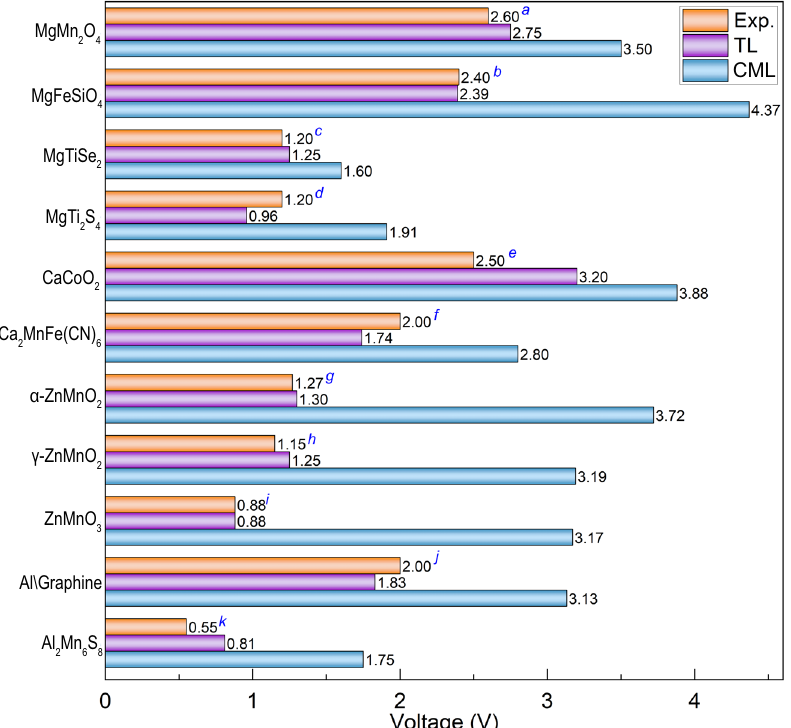
Fig. 4 Comparing the predicted voltages with the TL and conventional ML models with the available experimental values. a Ref. 58 . b Ref. 59 . c Ref. 60 . d Ref. 61 . e Ref. 62 . f Ref. 63 . g Ref. 64 . h Ref. 50 . i Ref. 65 . j Ref. 66